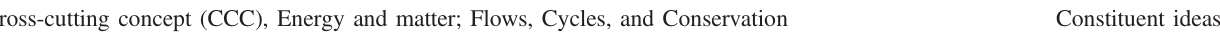
TABLE III. NGSS energy statements in the cross-cutting concepts (energy and matter) and their constituent ideas. Cross-cutting concept (CCC), Energy and matter; Flows, Cycles, and